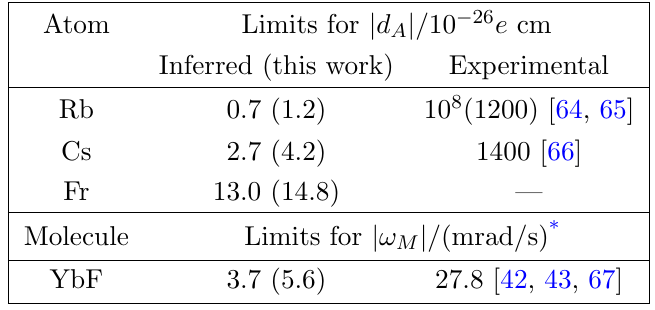
Table 6 . Model-independent limits for paramagnetic systems from our global (cid:12)ts; the numbers in brackets correspond to the (cid:12)t including paramagnetic systems,